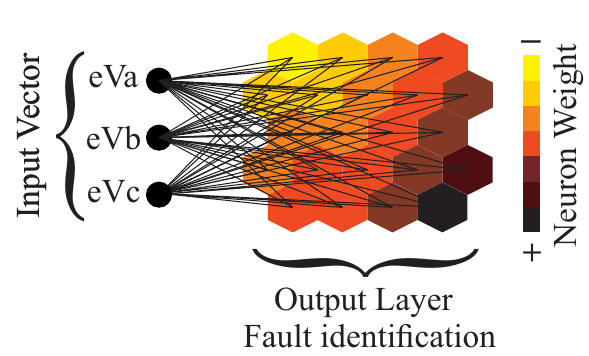
Figure 5. Self Organizing Map architecture for faults identification.